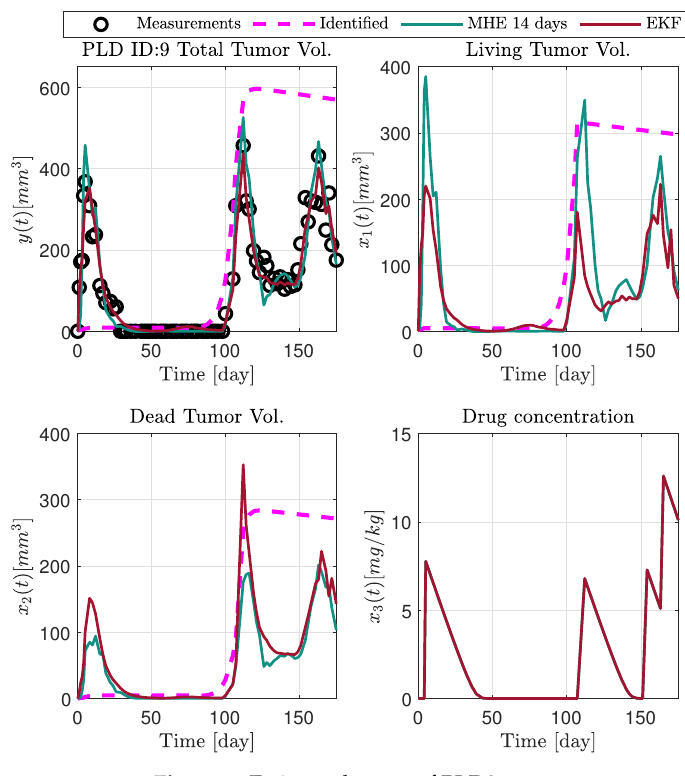
Figure 7. Estimated states of PLD9 mouse.